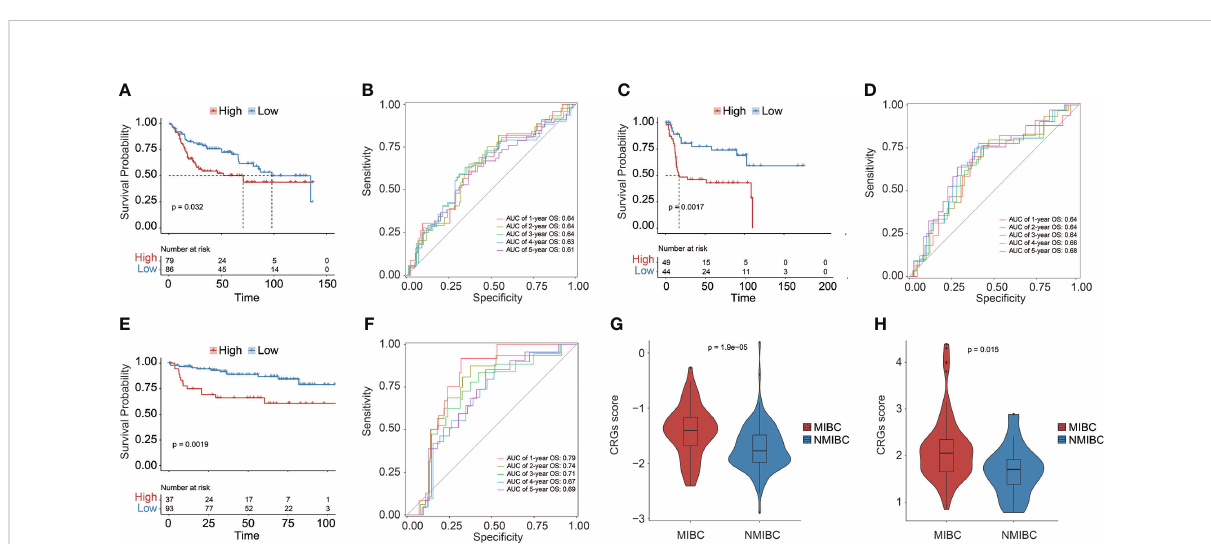
FIGURE 3 The prognostic CRG signature was validated in three independent datasets: GSE13507, GSE31684, and GSE32548. Kaplan – Meier curve analysis to compare OS between high-risk and low-risk groups in GSE13507 (A) , GSE31684 (C) , and GSE32548 (E) . The receiver operating characteristic curve (ROC) analysis for validating the ability of CRG signature in prognosis prediction in GSE13507 (B) , GSE31684 (D) , and GSE32548 (F) . Comparison analysis of the CRG scores between MIBC and NMIBC patients in GSE13507 (G) and GSE31684 (H)